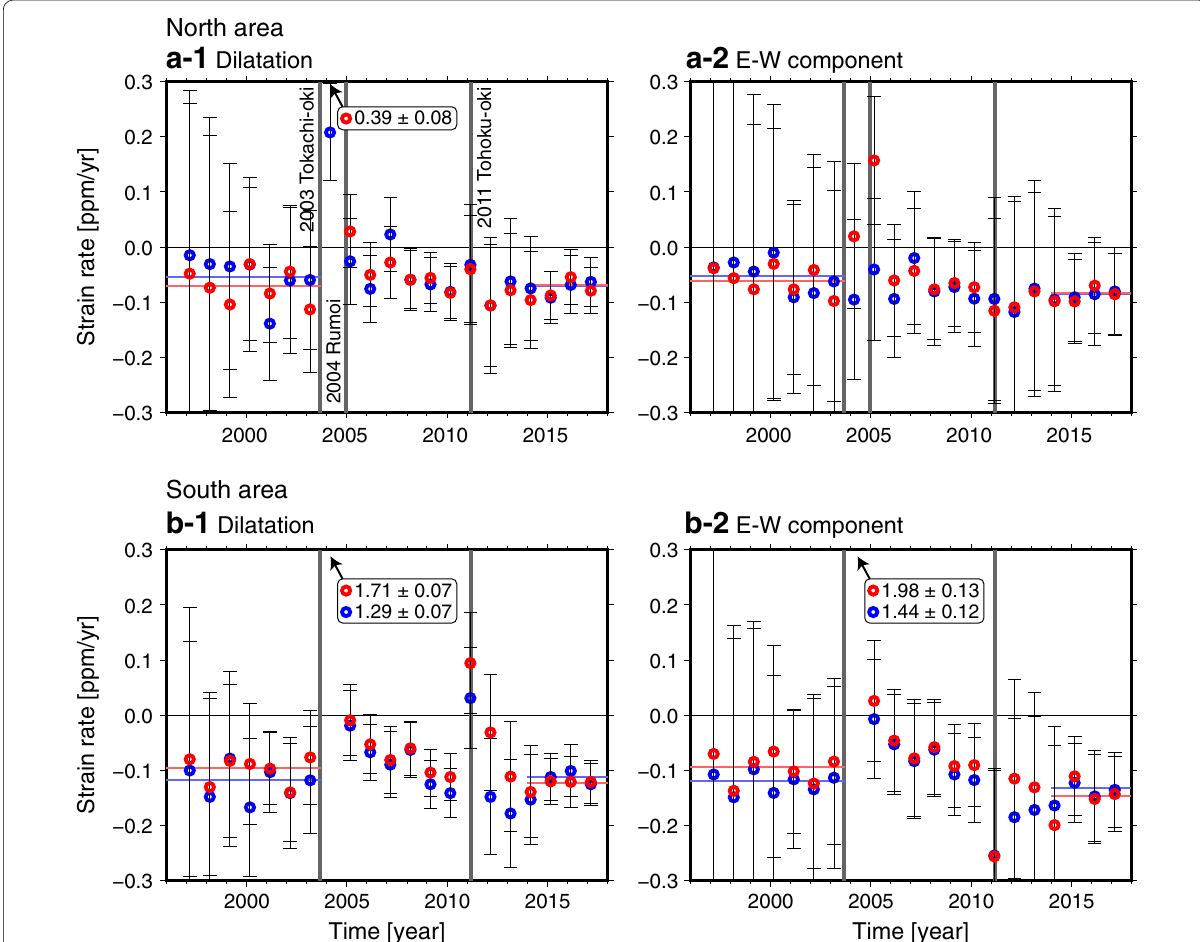
Fig. 3 Temporal changes in the strain rate: a for northern areas. a-1 Dilatation in the two northern areas (red: 141.95°E, 44.35°N and blue: 141.95°E, 44.60°N). Vertical bars indicate the timing of large earthquakes (i.e., the 2003 Tokachi-oki, 2011 Tohoku-oki, and 2004 Rumoi earthquakes). Error bars are 0.5 σ. The horizontal colored lines behind the March 1996 to September 2003 and January 2014 to December 2017 periods are the strain rates − shown in Fig. 2 estimated from the two velocity fields. Each color corresponds to a grid location. a-2 is identical to a-1 but for the E–W component. b Southern areas. b-1 and b-2 are identical to a-1 and a-2 , respectively, but are for southern areas (red: 141.70°E, 42.85°N and blue: 141.70°E,